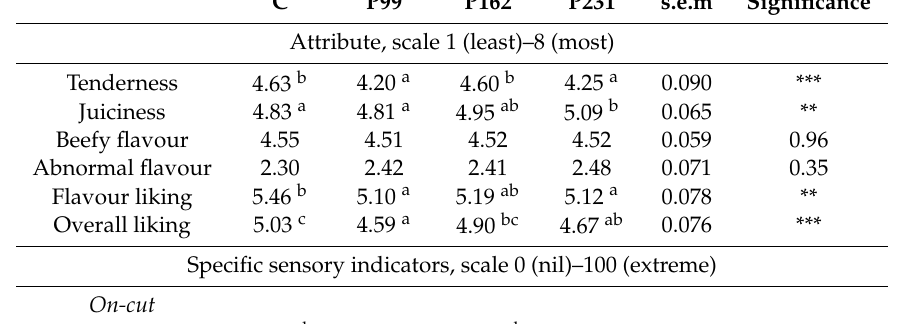
Table 5. Sensory characteristics of longissimus thoracis muscle from bulls raised on either a concentrate-based system (C) or pasture-based systems (P) incorporating 99 days (P1), 162 days (P2) or 231 days (P3) of grazing period prior to indoor finishing on a concentrate-based diet.